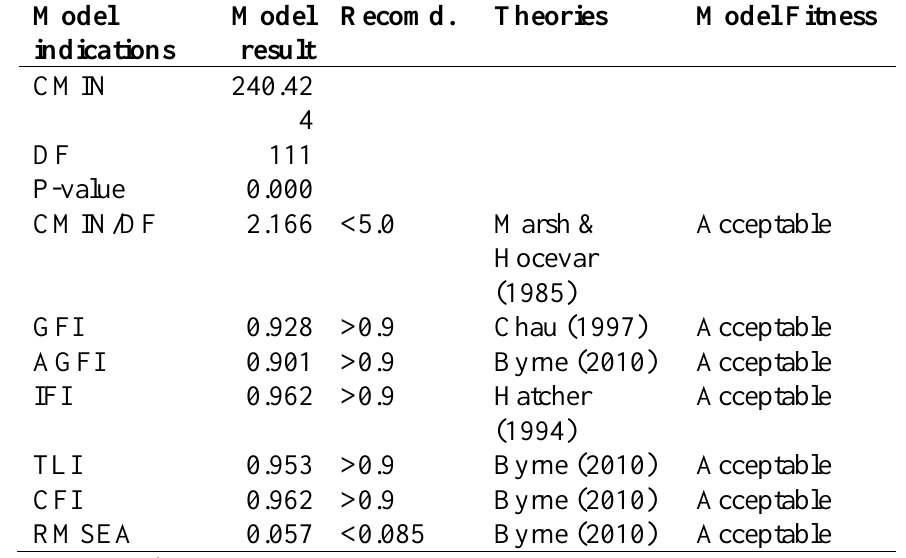
Figure 2. Fit Model Table 4: Measurement Model